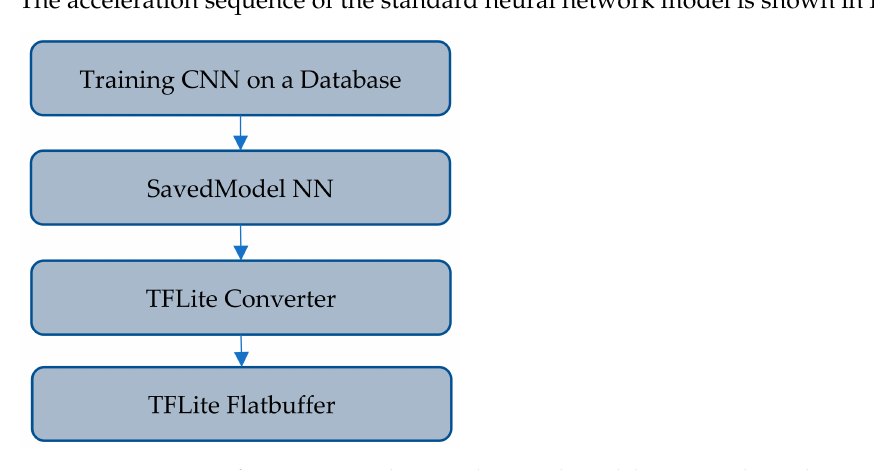
Figure 10. Sequencer for converting the neural network model to an accelerated TFLite